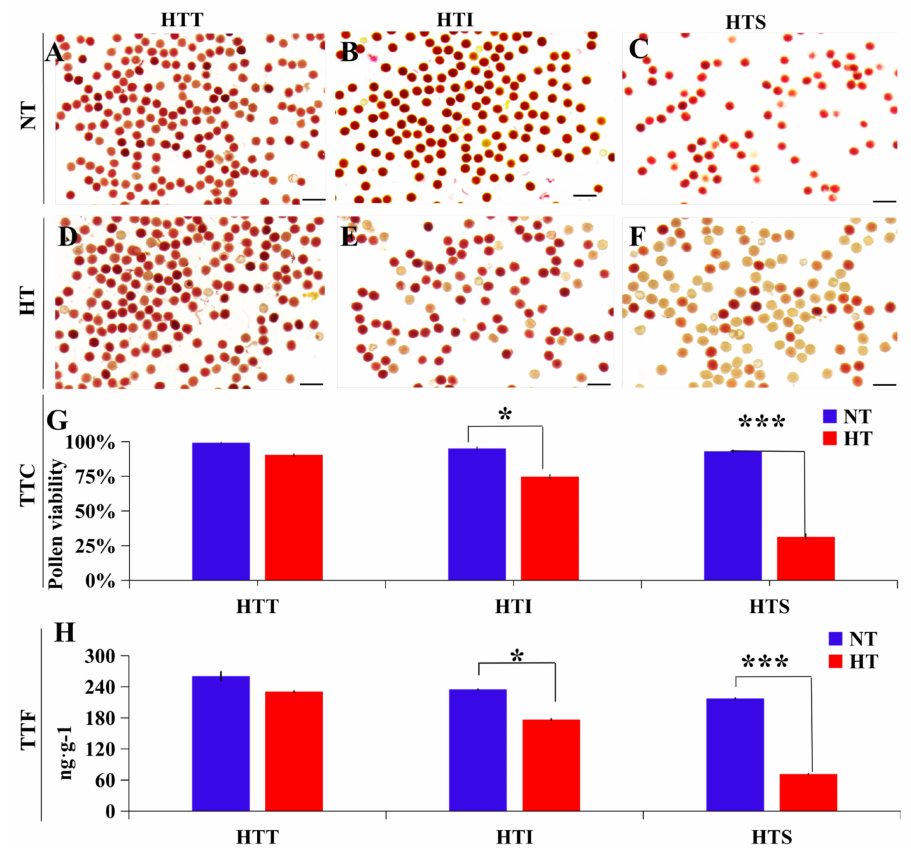
Figure 4. Pollen viability analysis via PollenDetect recognition of TTC staining images corresponding with the TTF quantitative analysis results. ( A – C ) Pollen TTC staining images of HTT ( A ), HTI ( B ), and HTS ( C ) cotton lines under NT conditions. Bars: 100 µ m. ( D – F ) Pollen TTC staining images of HTT ( D ), HTI ( E ), and HTS ( F ) cotton lines under HT conditions. Bars: 100 µ m. ( G , H ) TTC